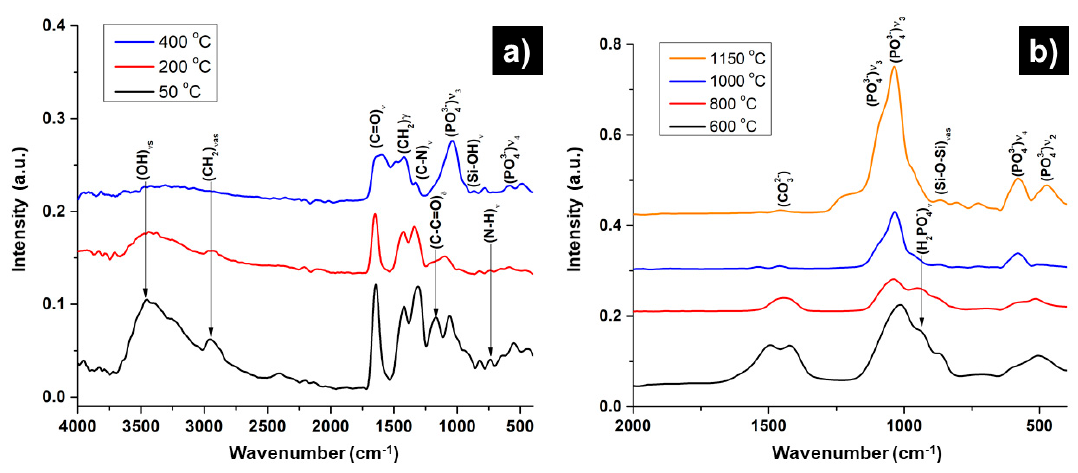
Figure 1. ( a ) Infrared spectra of the SiO 2 –HA–polyvinylpyrrolidone (PVP) fibers at 50, 200 and 400 °C, and ( b ) the infrared spectra of the SiO 2 –HA at 600, 800, 1000 and 1150 °C.